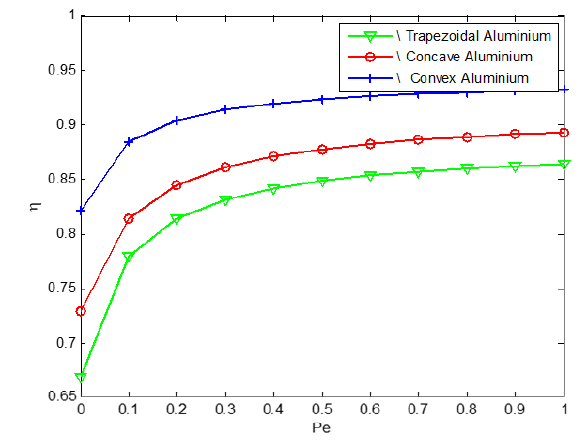
Figure 17. Variation in efficiency with Peclect number for Aluminium porous